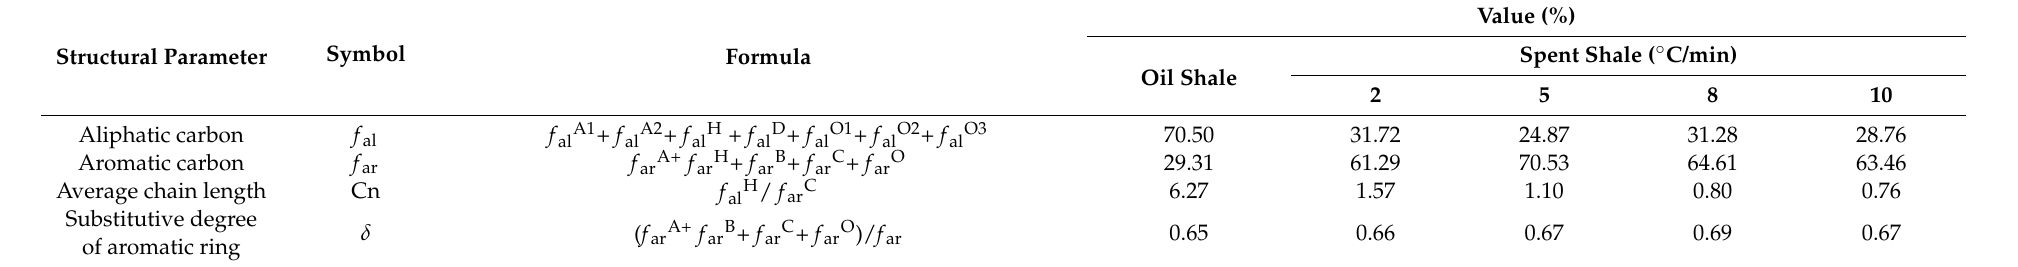
Table 3. Distribution of structural carbons in the 13 C NMR spectra of Jimsar oil shale and its spent shale, obtained at different heating